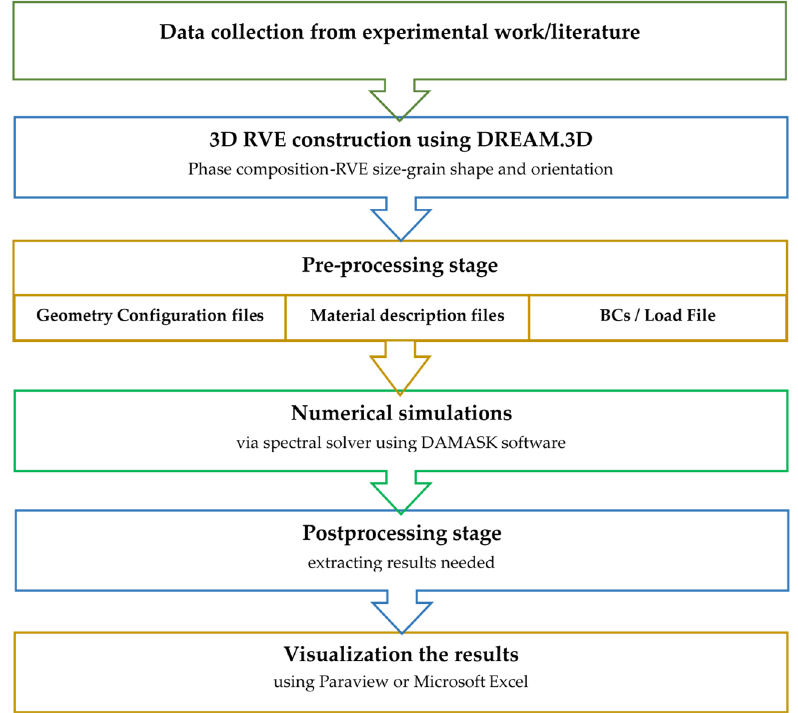
Figure 1. A simple flow chart showing the methodology adopted and data flow in this study.